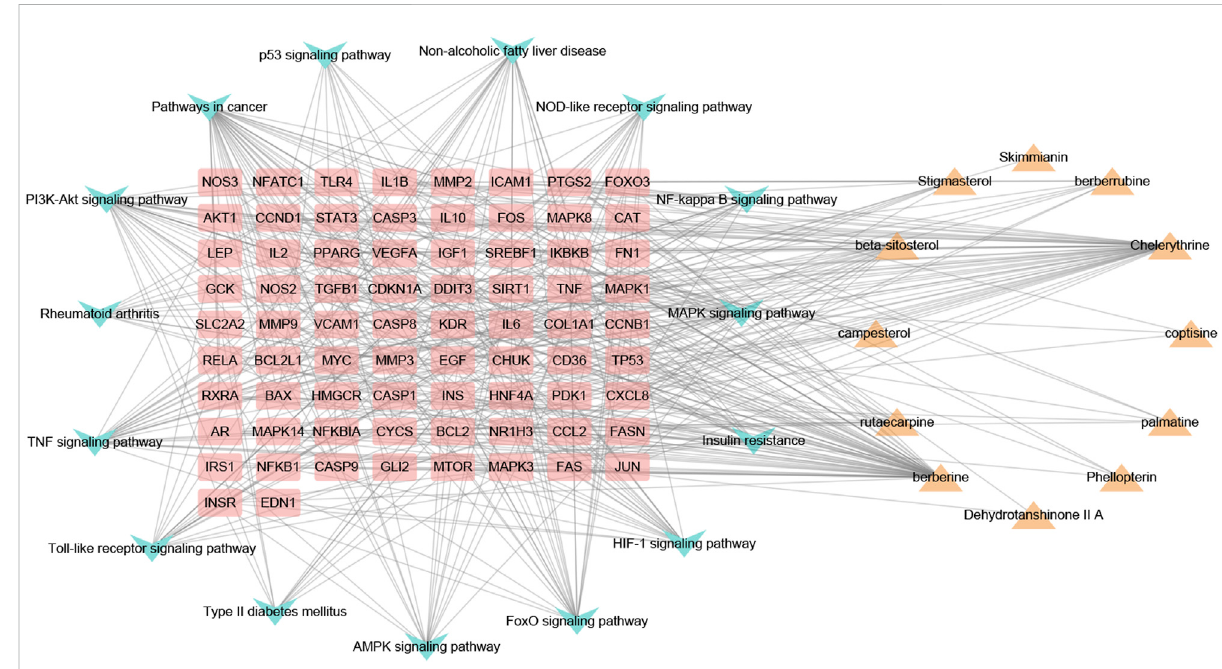
FIGURE 6 The component-target-pathway network of CP. Yellow triangle nodes represent active ingredients, pink rectangles represent nodes target proteins, blue arrowhead nodes represent pathways, and the lines represent the interactions between them.